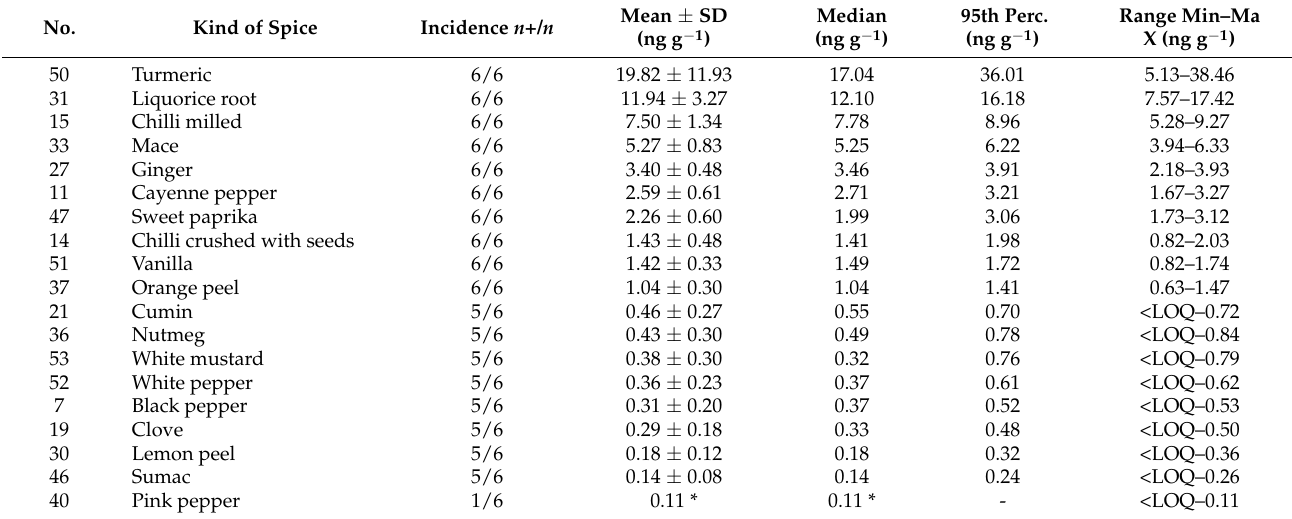
Table 3. The concentrations of OTA in a total of 20 positive single-kind spices available on the Czech market.